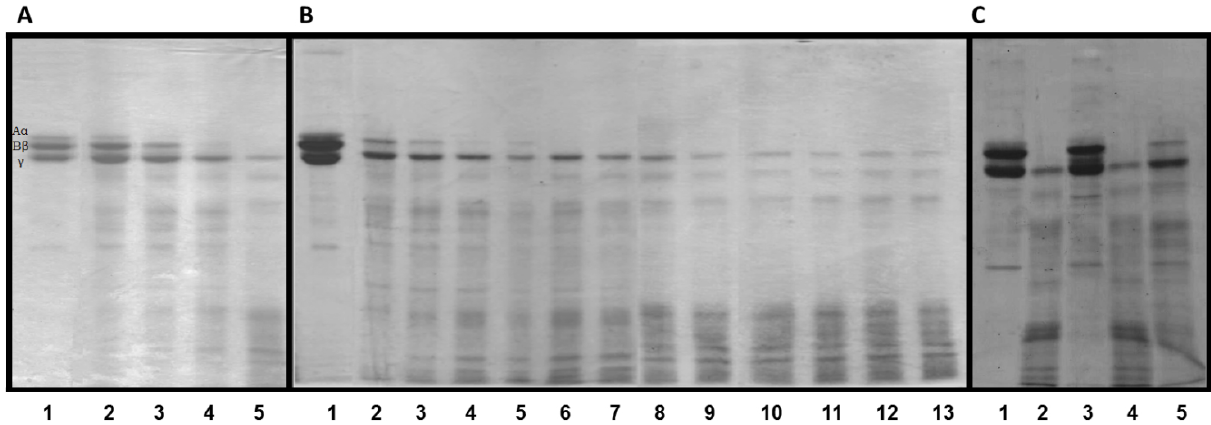
Figure 3. Fibrinogenolytic activity of C. urens fraction F1.0 analyzed on 12% SDS-PAGE under reducing conditions. ( A ) Evaluation of the dose-dependence of hydrolysis of fibrinogen by proteins fraction F1.0. Lane 1: pure fibrinogen (50 µg); Lane 2: fibrinogen + 0.02 µg/µL; Lane 3: fibrinogen + 0.04 µg/µL; Lane 4: fibrinogen + 0.09 µg/µL; Lane 5: fibrinogen + 0.18 µg/µL. The fraction F1.0 and fibrinogen were incubated at 37 °C for 1 h; ( B ) Kinetics of fibrinogen hydrolysis by fraction F1.0. Lane 1: pure fibrinogen (50 µg) incubated for 120 min without C. urens fraction F1.0, Lanes 2–11: fibrinogen (50 µg) incubated for with C. urens fraction F1.0 (0.18 µg/µL) at 37 °C for 30 sec, 1, 2, 3, 4, 5, 10, 15, 20, 30, 60 and 120 min in 0.05 M Tris-HCl, 0.15 M NaCl, pH 7.5 buffer; ( C ) Evaluation of the effect of specific inhibitors on the hydrolysis of fibrinogen. Lane 1: pure fibrinogen (50 µg); Lane 2: fibrinogen + fraction F1.0 C. urens protein (0.18 µg/µL); Lanes 3–5: fraction F1.0 of C. urens (0.18 µg/µL) pre-incubated with different inhibitors for 15 min (1 mM E-64, 1 mM PMSF and 1 mM EDTA, respectively), followed by incubation with 50 μ g of bovine fibrinogen 37 °C for 1 h. The gels were stained with Coomassie brilliant blue